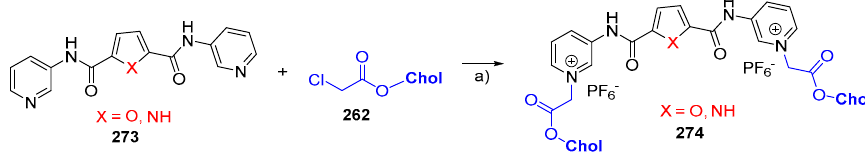
Scheme 67. Synthesis of cholesteryl-bisamides. Reagents and conditions: a ) 1. DMF, MeCN, reflux,